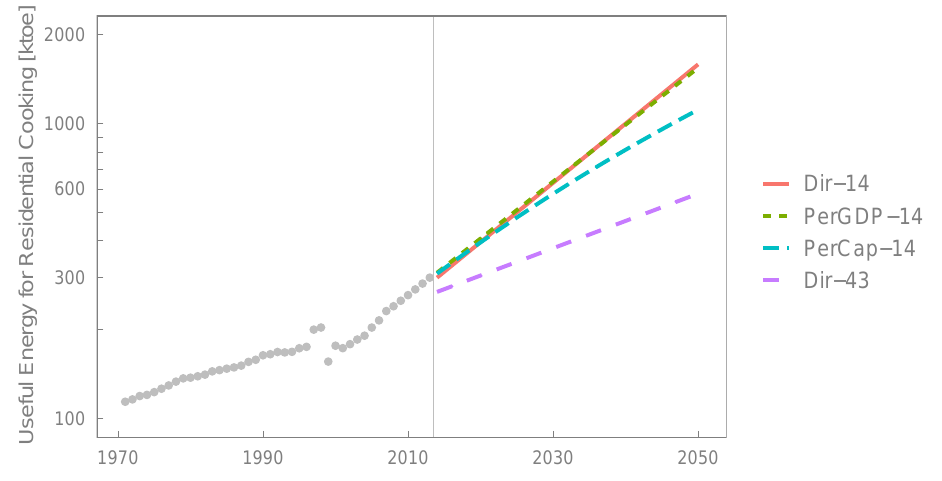
Figure 8. Four Models of Useful Energy for Residential Cooking in Honduras